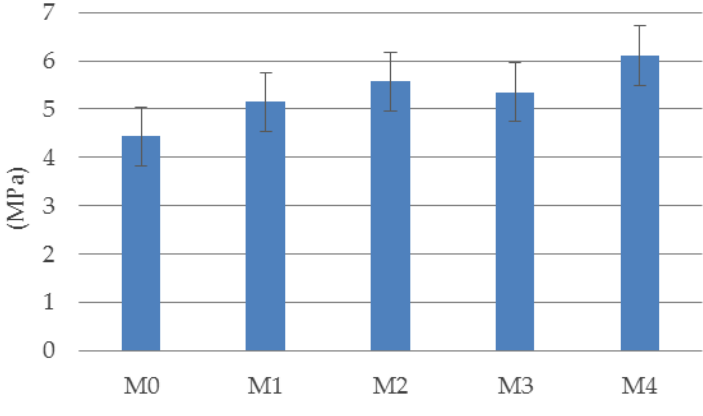
Figure 7. Limit of proportionality (LOP) of tested materials. Table 3. The mean residual flexural tensile strength corresponding with CMOD